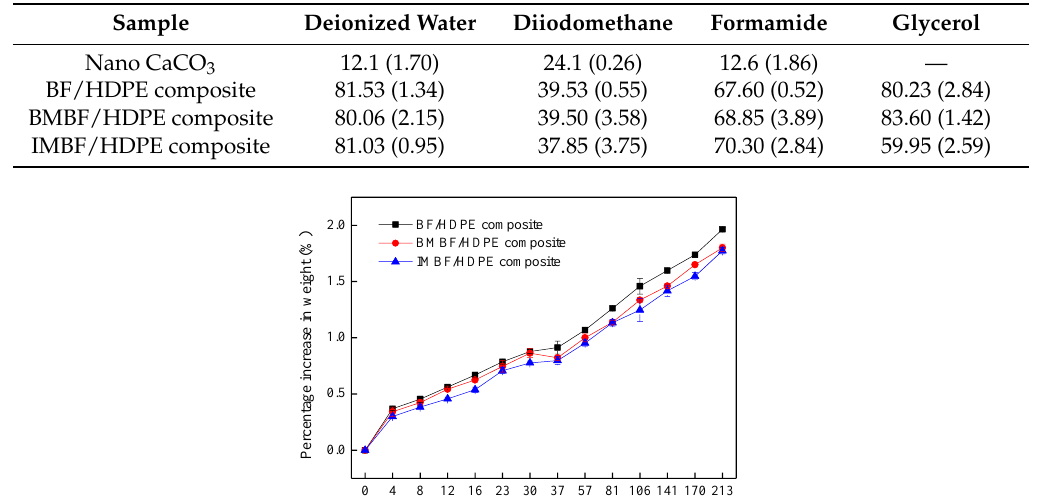
Table 2. Static contact angles (°).